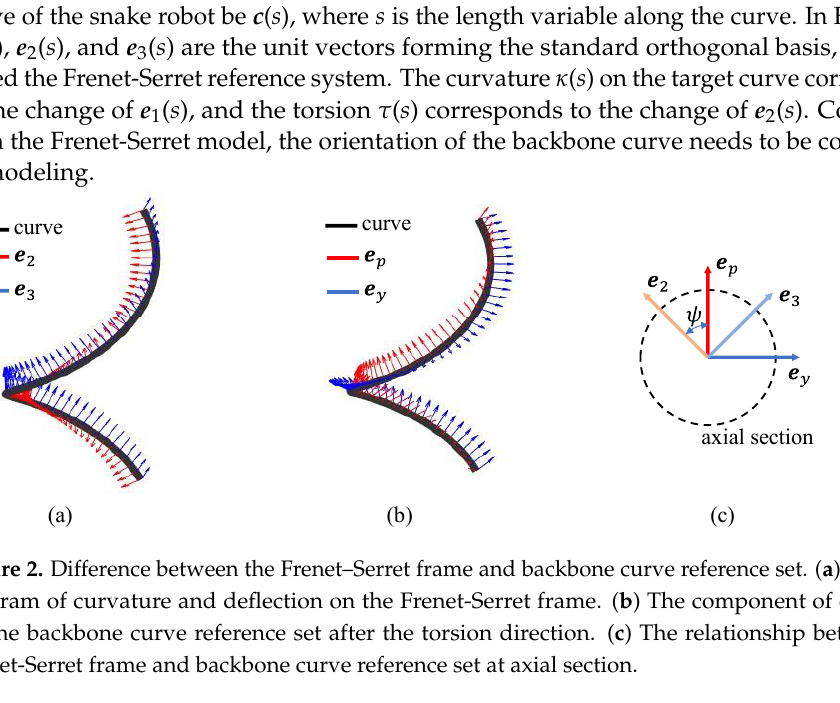
Figure 2. Difference between the Frenet – Serret frame and backbone curve reference set. ( a ) Direction diagram of curvature and deflection on the Frenet-Serret frame. ( b ) The component of curvature on the backbone curve reference set after the torsion direction. ( c ) The relationship between the Frenet- Serret frame and backbone curve reference set at axial section.